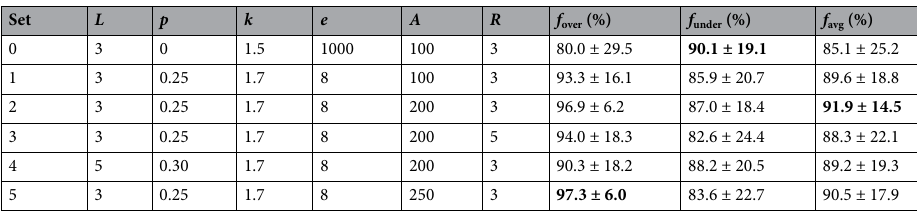
Table 1. Results of the tuning procedure for different sets of parameters of the clustering algorithm. Values in bold highlight the maximum for each metric. See “Methods” for a detailed description of each parameter and metric. L size of the searching window in space, p fraction of cells in the surrounding to detect a core cell, k mid-point of the logistic curve, e steepness of the logistic curve, A minimum size of the 2D clusters, R size of the searching window in